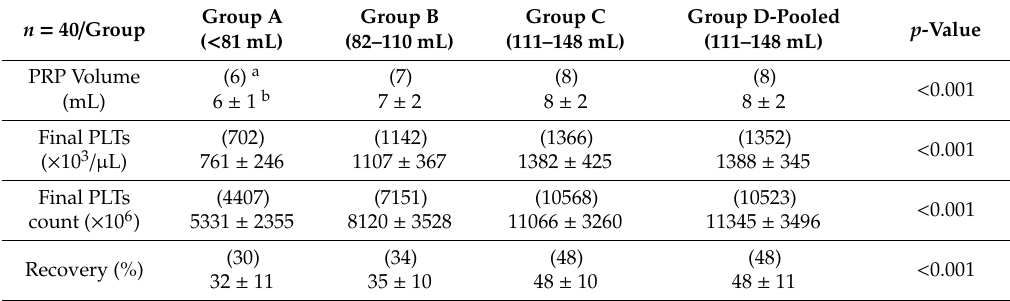
Table 2. Characteristics of platelet rich plasma (PRP) distributed in the four groups. Statistically significant di ff erences were observed in final volume ( p < 0.001), PLT concentration ( p < 0.001), PLT number ( p < 0.001) and recovery ( p < 0.001) between all groups. a The values represented are medians. b The values are represented as mean ±